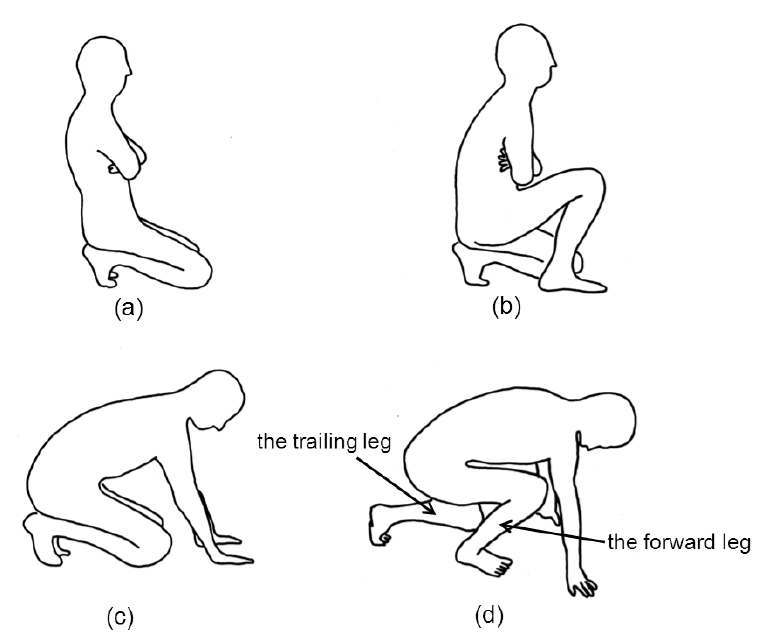
Fig.1 Ways of rising from various kneeling conditions (a) rising with legs parallel (arms not used), (b) rising with one foot forward (arms not used), (c) rising with legs parallel (arms used), (d) rising with one foot forward (arms